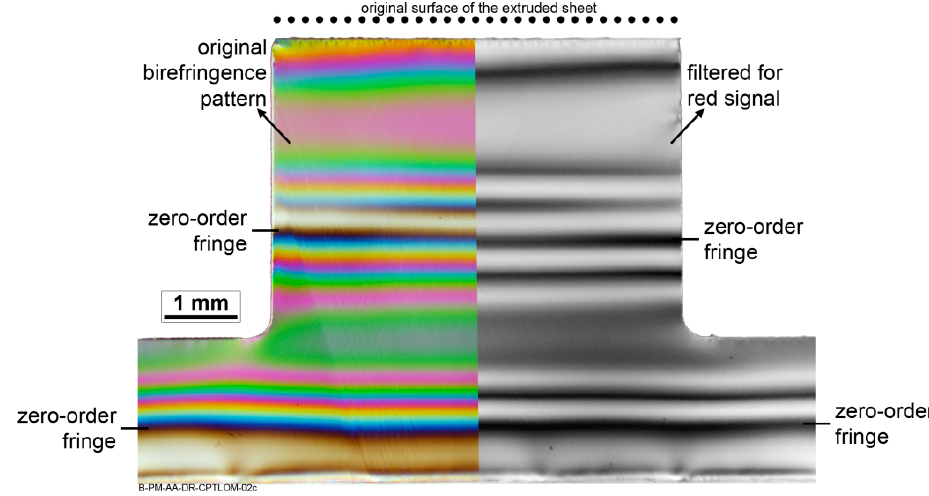
Figure 4. Transmitted-light optical microscopy with crossed polarizers (CP-TLOM) of the PEI base material. Left-hand image is the original output; right-hand image is filtered for red signal only. Adapted from [19].